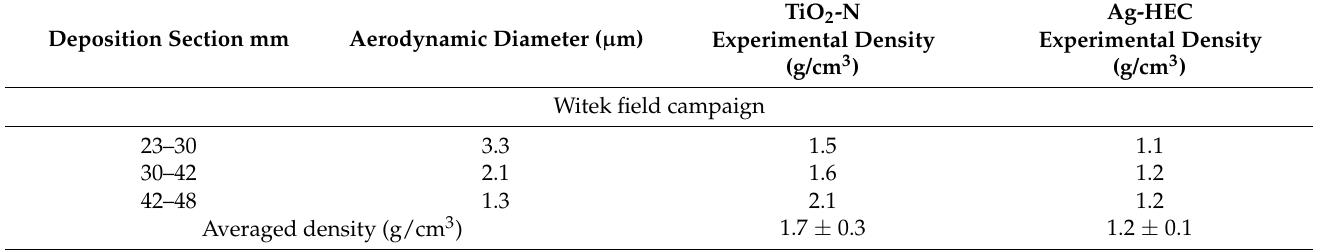
Table 4. Direct particle densities measured at the Witek monitoring campaign by